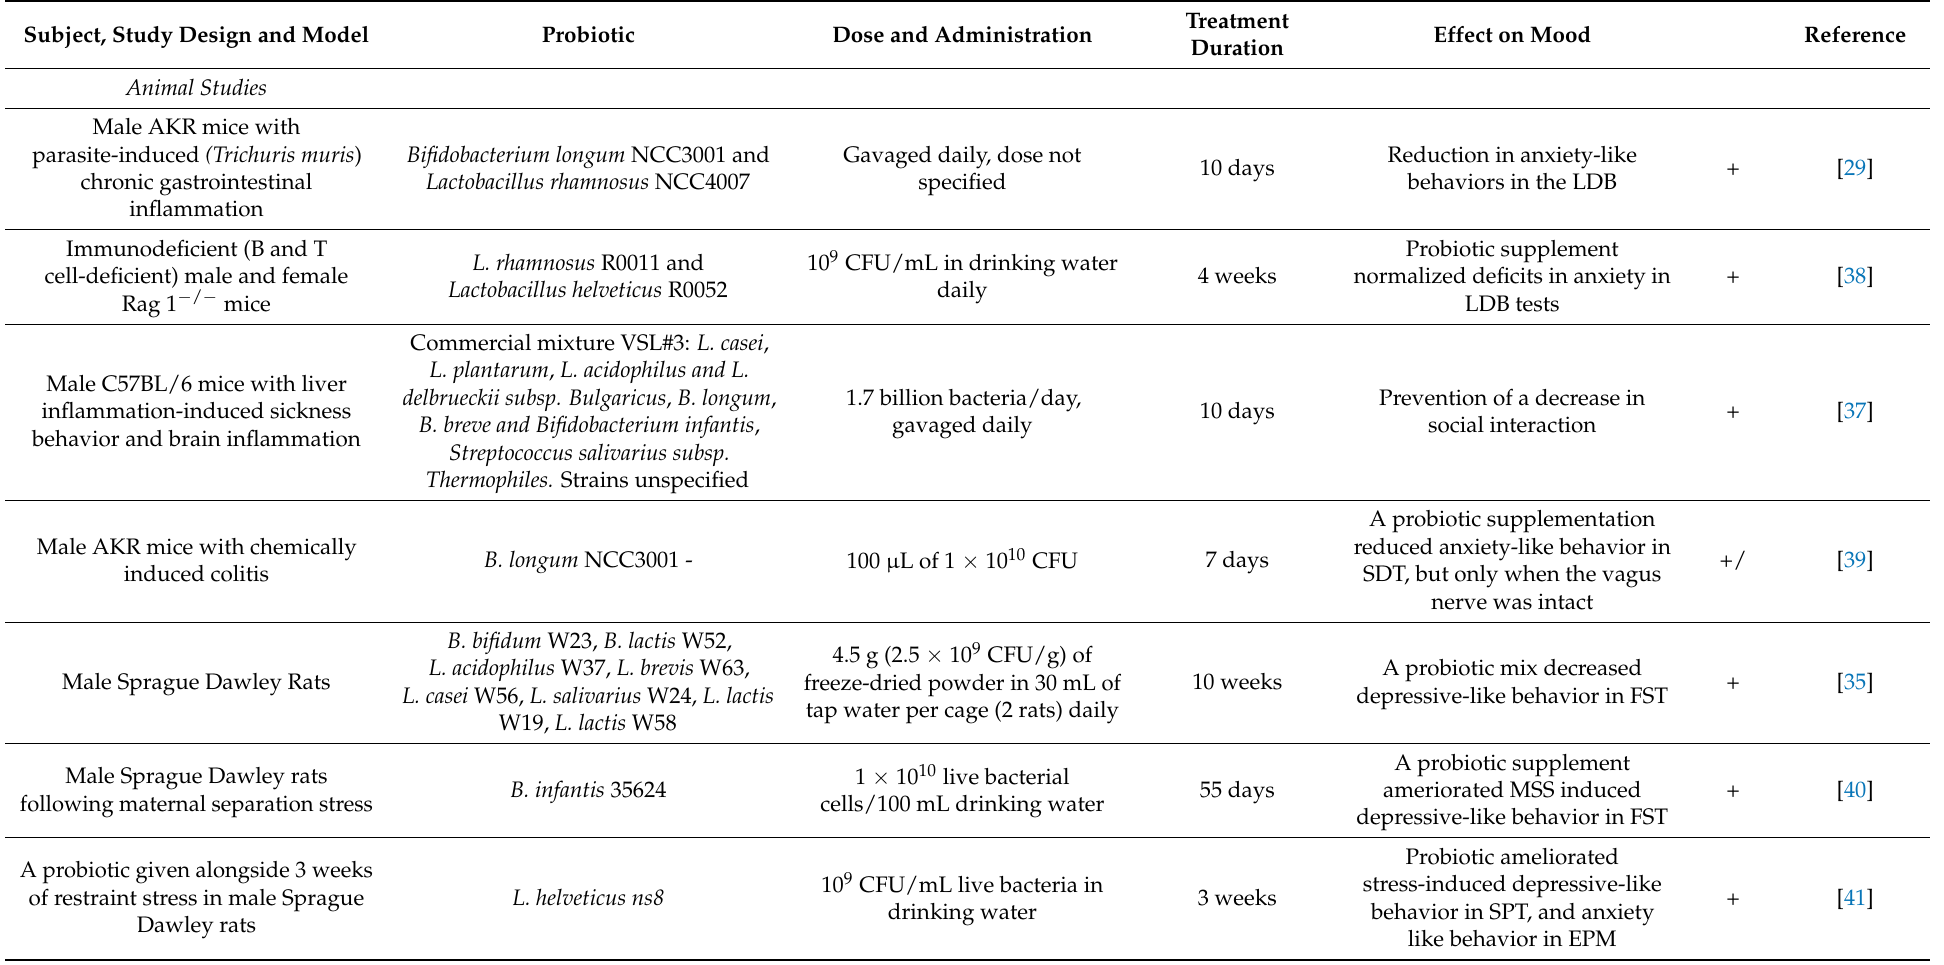
Table 1. Summary of studies testing the effects of probiotic supplements on mood. Effect on mood is indicated with: + for a positive effect on mood, − for a negative effect on mood, and / for no effect on mood. Abbreviations: LDB, Light Dark Box; SDT, Step Down Test; FST, Forced Swim Test; SPT, Sucrose Preference Test; PSS, Perceived Stress Scale; BAI, Beck